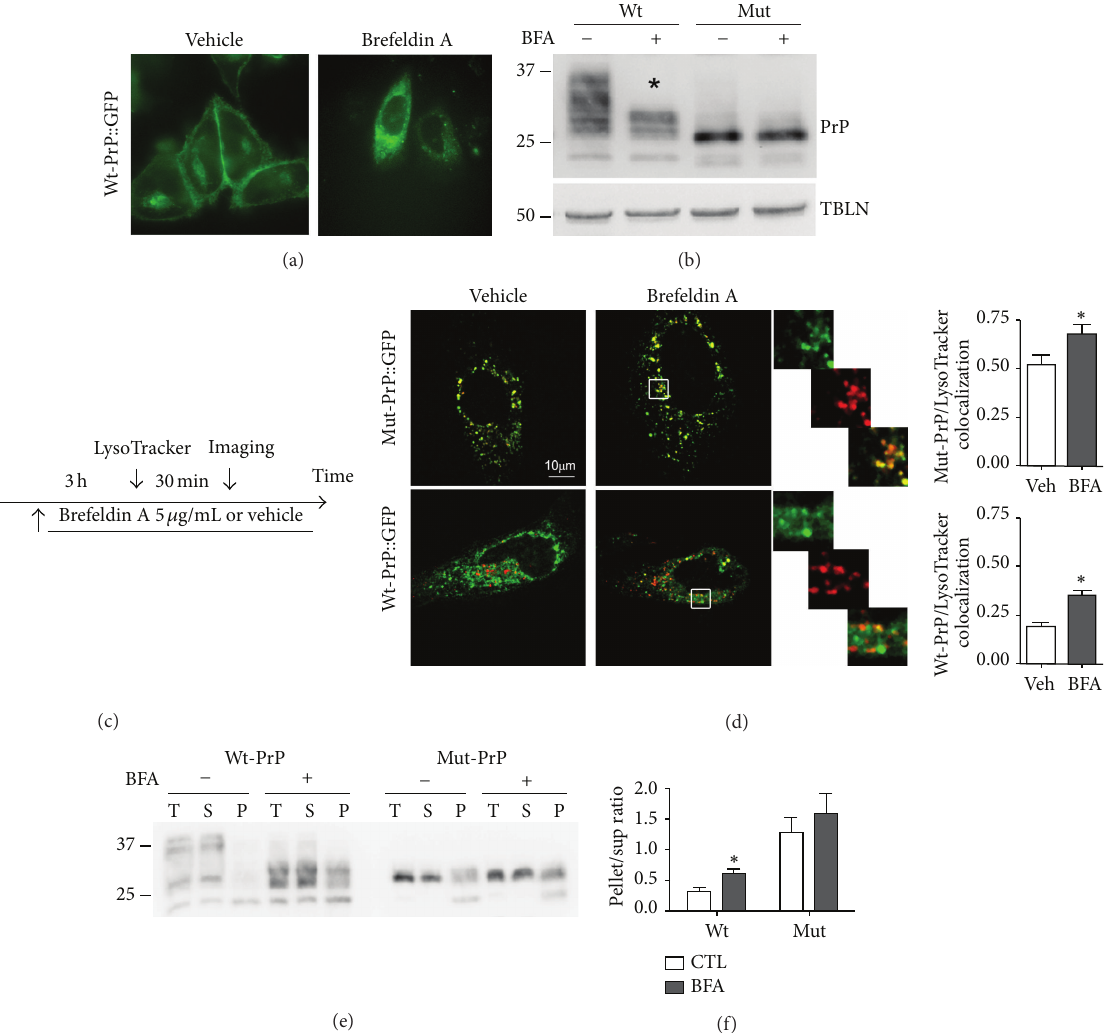
Figure 4: An intact Golgi is not essential for the delivery of Mut-PrP to LysoTracker positive vesicles. (a) Golgi disruption by Brefeldin A (BFA) (5 𝜇 g/mL for 3 h) was confirmed by the absence of Wt-PrP signal on the plasmalemma of HeLa cells expressing Wt-PrP::GFP, compared with vehicle-treated cells sampled at the same time point. (b) Functional disruption of Golgi by BFA was biochemically confirmed by the absence of complex glycans ( ∗ ) on Wt-PrP, following Western blot of total cell lysates, compared with vehicle-treated ( − ) cells. Mut-PrP does not acquire complex sugars and as such is unaffected by BFA. PrP was detected with D13 antibody. (c) Experimental paradigm; times are relative to the completion of the transfection protocol. BFA (5 𝜇 g) was added at 5.5 hours, at the earliest detection of PrP signal, LysoTracker Red (50 nM) was added 30 minutes prior to the start of imaging at 9 hours, and images were collected by 10 hours. (d) Immunofluorescence of live cells expressing GFP-tagged Mut-PrP after treatment with vehicle or BFA. Green (PrP::GFP) and red (LysoTracker) channels are displayed as merged. Separate channels for the boxed areas of BFA treated cells are magnified and displayed to the right of the merged images. Correlation coefficient analysis revealed a statistically significant increase in colocalization of PrP and LysoTracker after BFA treatment for both Wt-PrP and Mut-PrP. Wt-PrP veh = 0.1891 ± 0.0194 , BFA= 0.3505 ± 0.01997 ( 𝑛 = 28 cells, 𝑃 < 0.001 ); Mut-PrP veh = 0.5112 ± 0.05329 , BFA= 0.6710 ± 0.05438 ( 𝑛 = 23 cells, 𝑃 < 0.05 ). (e) BFA treatment increases the insoluble fraction of PrP. N2a cells stably expressing 3F4- tagged Wt- or Mut PrP were treated with BFA (5ug/mL for 3 h) or vehicle, and the insoluble fraction of PrP was separated by centrifugation at 16,000 × g, and equal volumes of the total (T), supernatant (S), and pellet (P) fractions were loaded and subjected to Western blot using the 3F4 mAb. (f) Densitometric quantification of (e), using Image One (BioRad) software. The fraction of insoluble Wt-PrP was significantly increased after BFA treatment ( 𝑃 < 0.05 , 𝑛 = 4 ), while the increase in insoluble Mut-PrP did not reach significance ( 𝑛 = 4